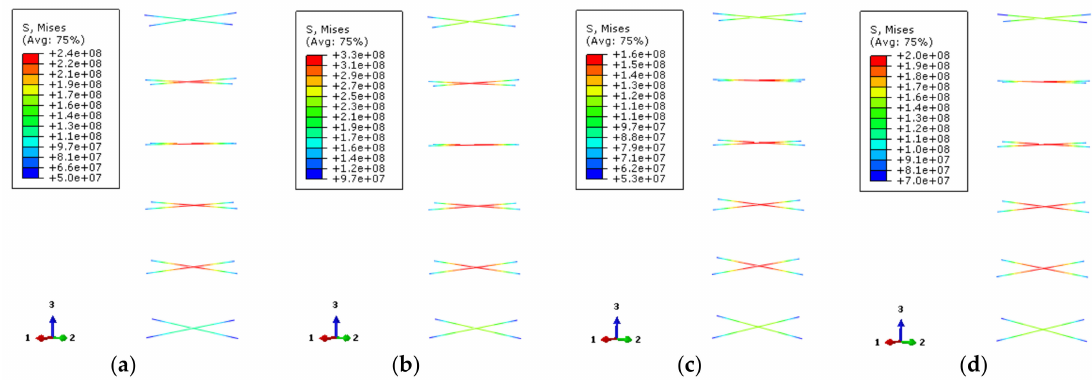
Figure 20. The Mises stress distribution of bar stiffeners ( a ) DS-200-0.75; ( b ) DS-200-1; ( c ) DS-600-0.75; ( d ) DS-600-1.